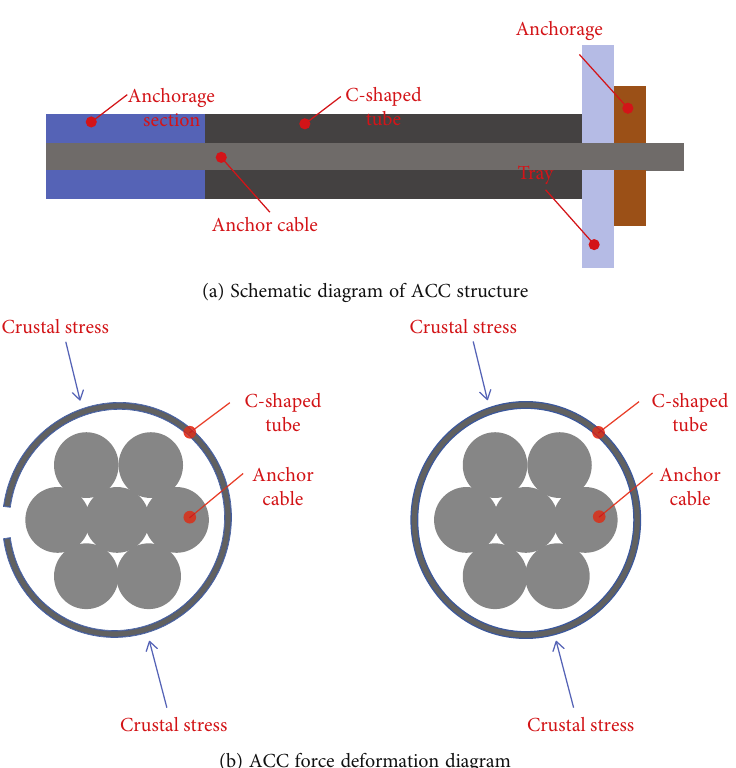
Figure 1: Schematic diagram of pipe and cable combination